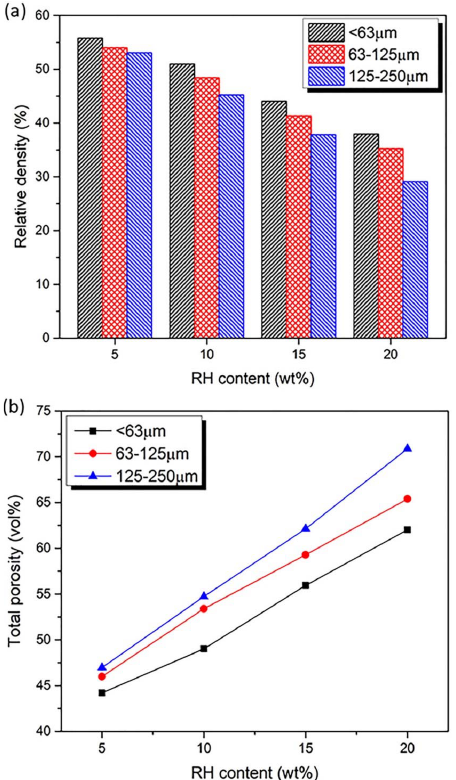
Figure 3. Variations of ( a ) relative density, and ( b ) total porosity of porous alumina ceramics with different weight contents of rice husk.